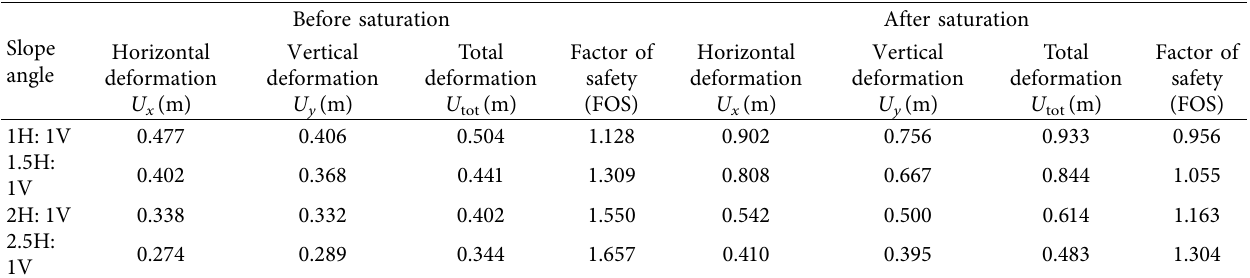
Table 3: FOS and slope deformation values for slope-2 by Plaxis 2D before and after